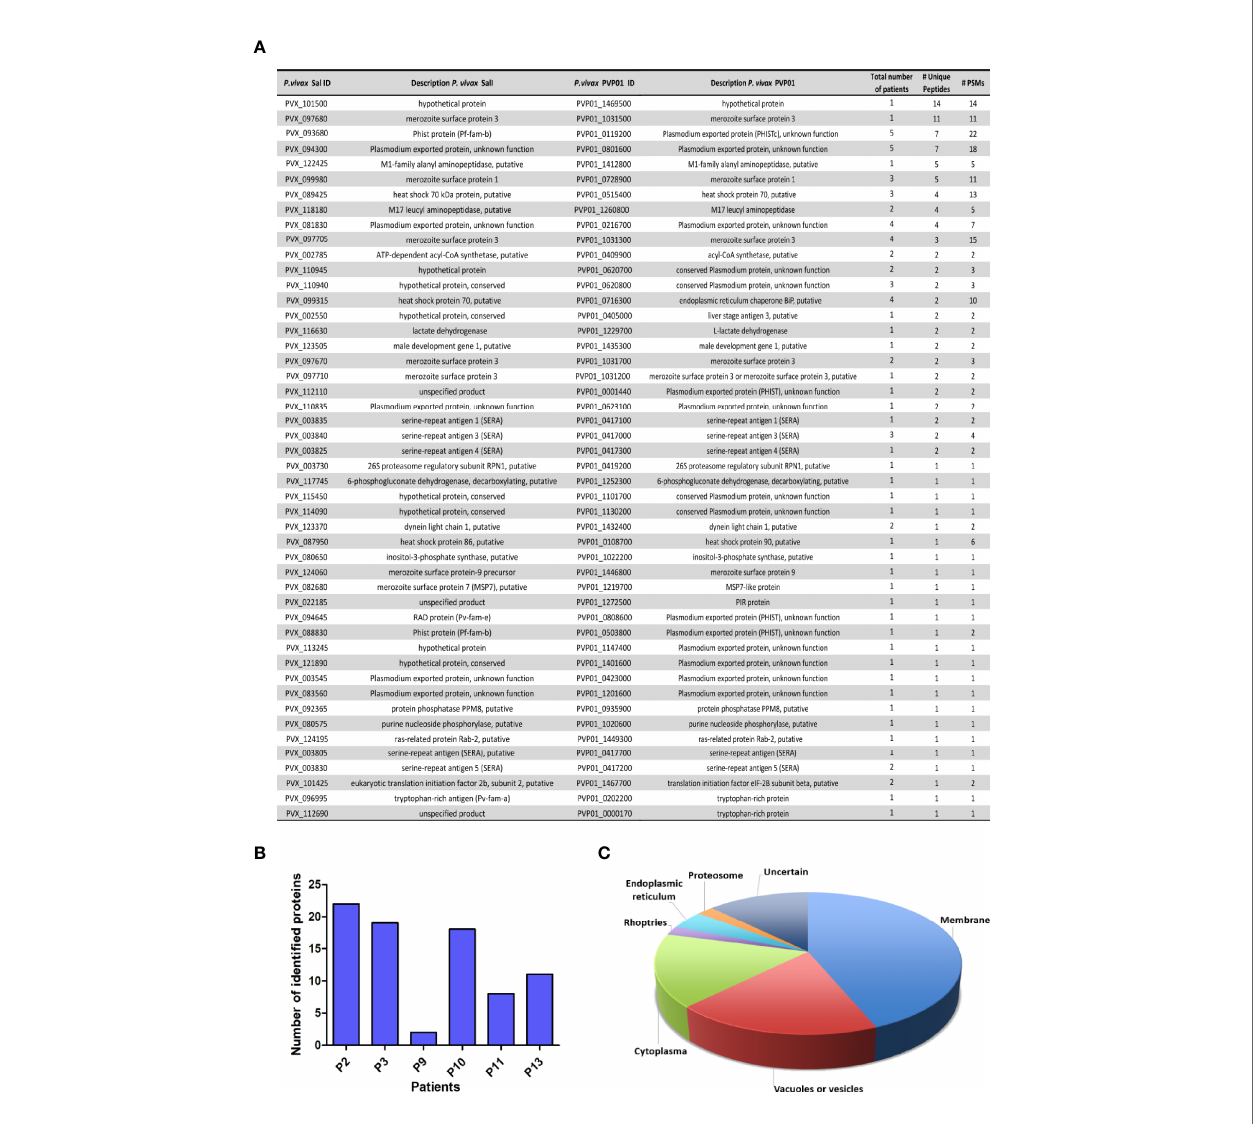
FIGURE 3 | P. vivax protein groups identi fi ed in proteomic analysis of CD71 + EVs isolated by direct immuno-af fi nity capture (DIC) from plasma of P. vivax patients. (A) Non-redundant P. vivax protein groups quanti fi ed in CD71 + EVs indicating Sal-I and PVP01 PlasmoDB accessions and descriptions, number of samples where they were identi fi ed, number of unique peptides and PSMs. Extended supporting data of these analysis can be found in Supplementary Excel File 1 . (B) Parasite protein groups distribution in P. vivax patients. (C) Pie chart showing predicted subcellular localization of parasite protein groups identi fi ed in CD71 + EVs. Subcellular compartment assignations were retrieved from Uniprot. In those cases where localization was unknown, predictions were performed by inference in orthologues of P. falciparum or homologues in